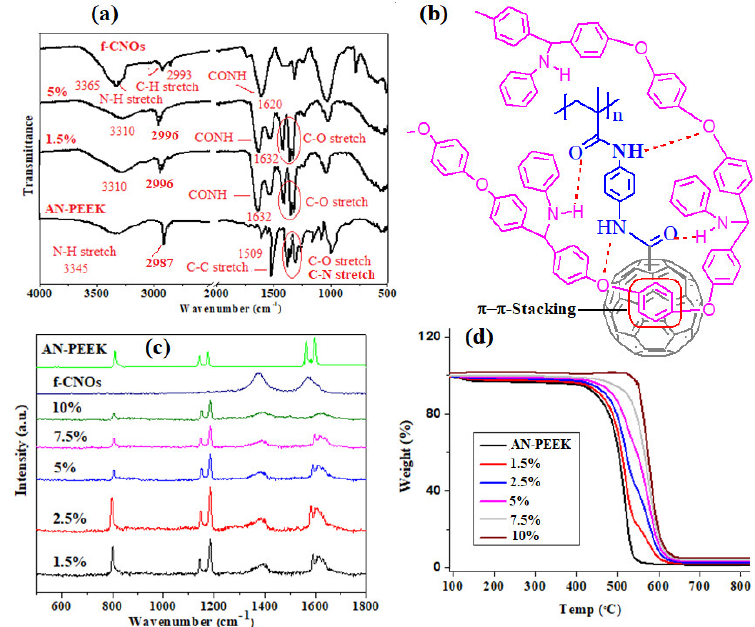
Figure 2. ( a ) FTIR of AN-PEEK and AN-PEEK/f-CNOs composite films. ( b ) Molecular structure of AN-PEEK/f-CNOs complex presenting the possible π-π-stacking between AN-PEEK, and f-CNOs and hydrogen bonding interactions between AN-PEEK, and PAPMA moiety. ( c ) Raman, and ( d ) TGA curves of AN-PEEK and AN-PEEK/f-CNOs nanocomposite films. The percentage fractions in the plots denotes wt% of the f-CNOs content in the AN-PEEK.